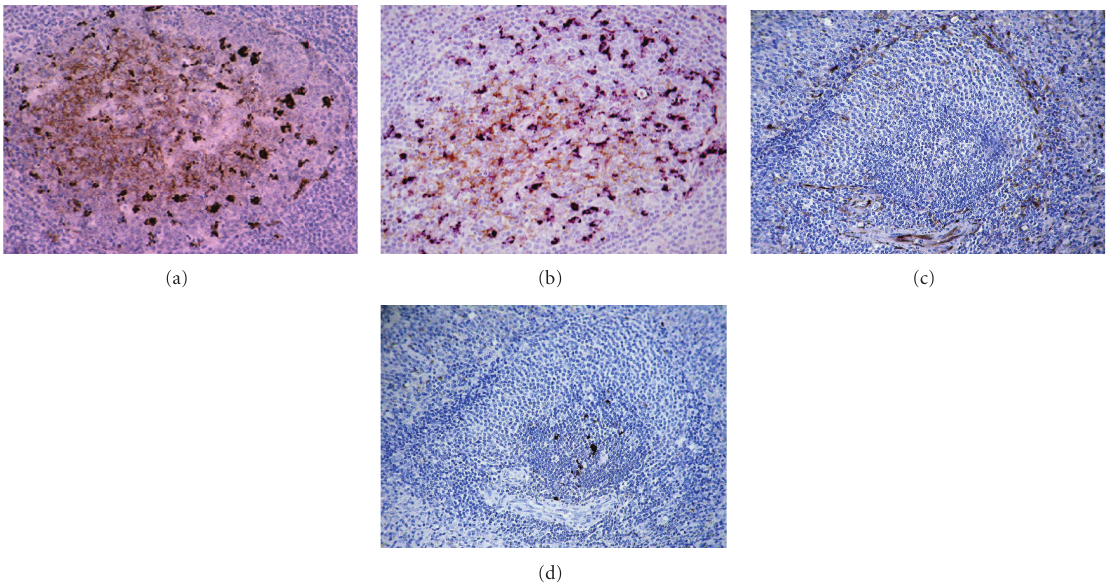
Figure 3: Scrapie infection in lymphoreticular tissues in ARQ/ARQ Su ff olk sheep. (a) PrP d accumulation is associated with both FDC and macrophages in clinically a ff ected sheep as shown by single IHC for PrP antibody R145. Peyer’s patches of the distal ileum. (b) PrP d within TBMs is N terminally truncated whereas PrP d associated with FDC is not [52]. TBM and FDC can be distinguished in tissue sections by using N or C terminal PrP antibodies. FDCs (brown), labelled by the N terminal antibody FH11, are in light zone whereas TBMs (purple), labelled by the C terminal antibody R145, are both in dark and light zones of secondary lymphoid follicles: double IHC for FH11 (brown, DAB substrate) and R145 (purple, VIP substrate). In spleen, nerve endings located in the marginal zone ((c), IHC for PgP9.5) do not colocalised with PrP d deposition ((d), IHC for R145). (a)–(d)